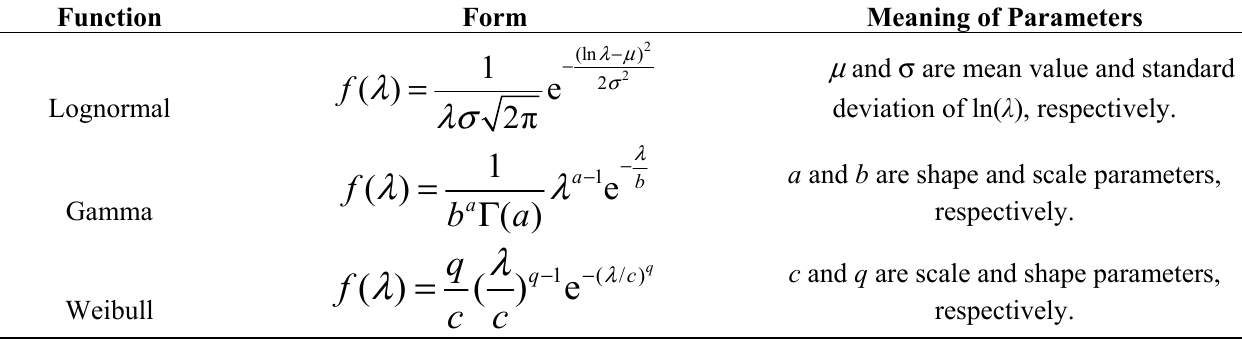
Table 1. Three fitted probability density functions (PDFs) for entrainment rate ( λ ) and related